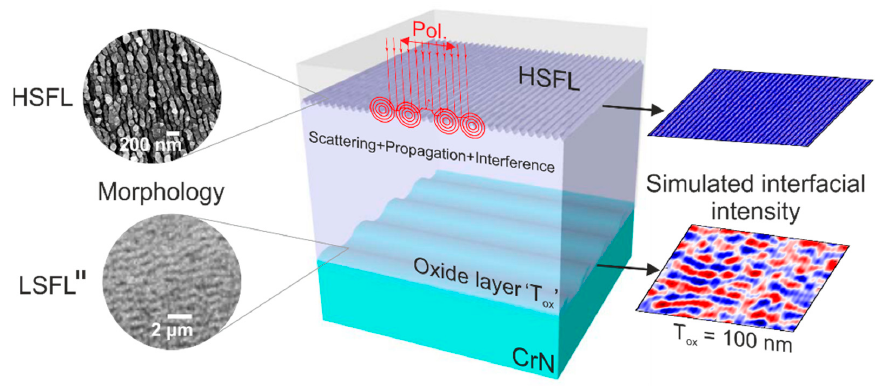
(cid:107) formation, featuring scattering, propagation and